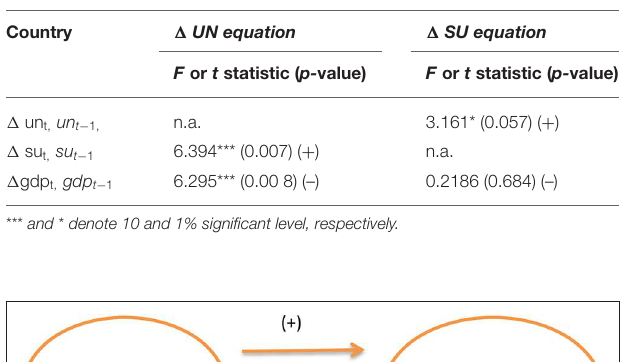
FIGURE 2 | Causal link among GDP, suicide rate, and unemployment